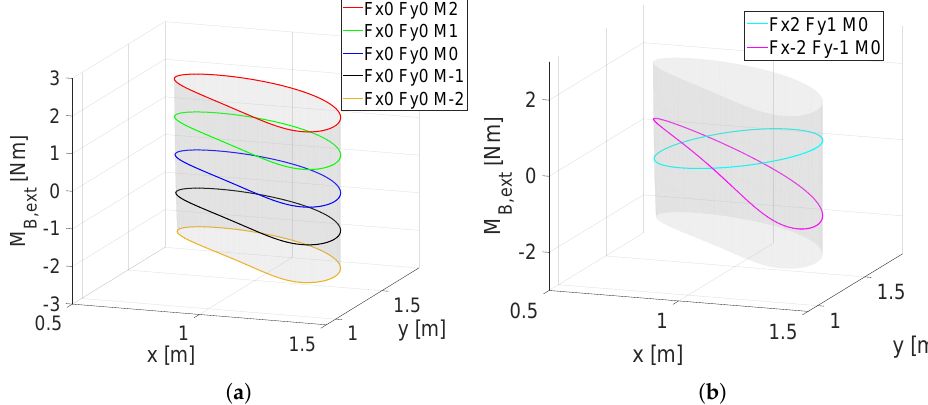
Figure 9. Trajectories for different load cases. ( a ) External constant moments. ( b ) External con- stant